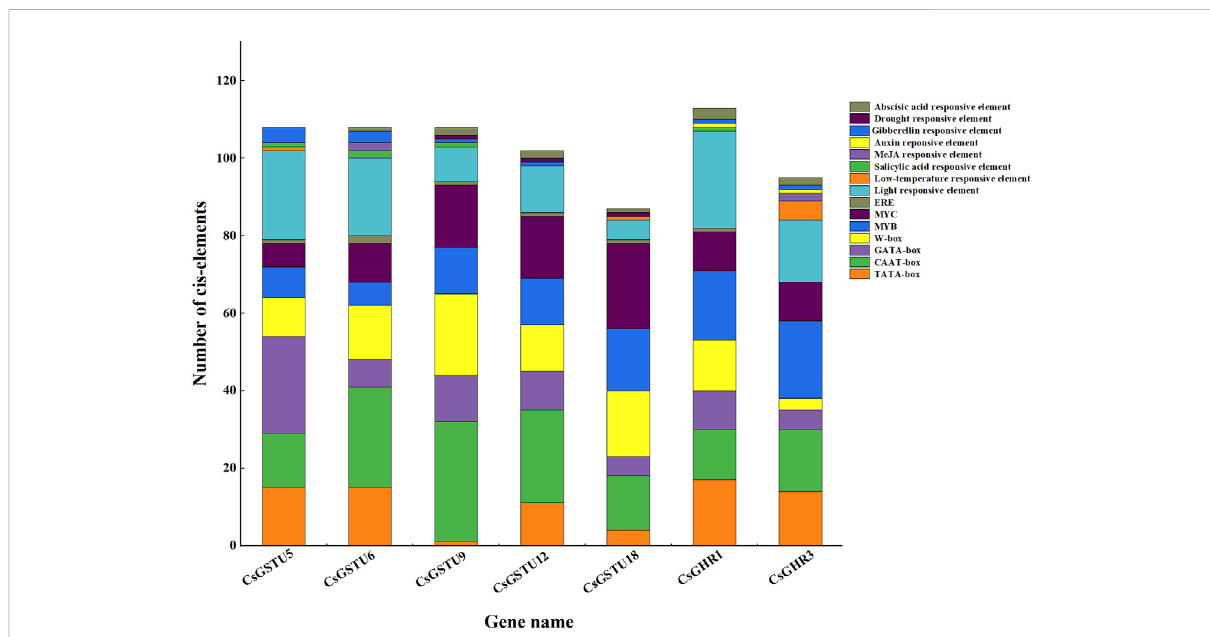
FIGURE 6 Putative cis-element analysis inpromoters of the seven CsGSTs candidates. The diverse cis -elements are shown using different colors, and the number of different cis -elements is represented by rectangle